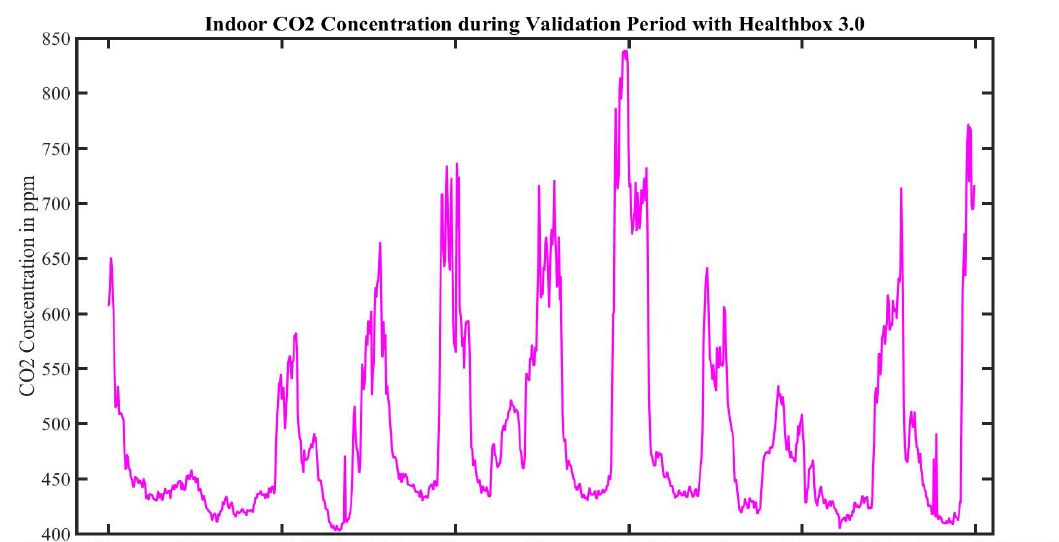
Figure 10. The carbon dioxide levels with Hybrid Ventilation system.